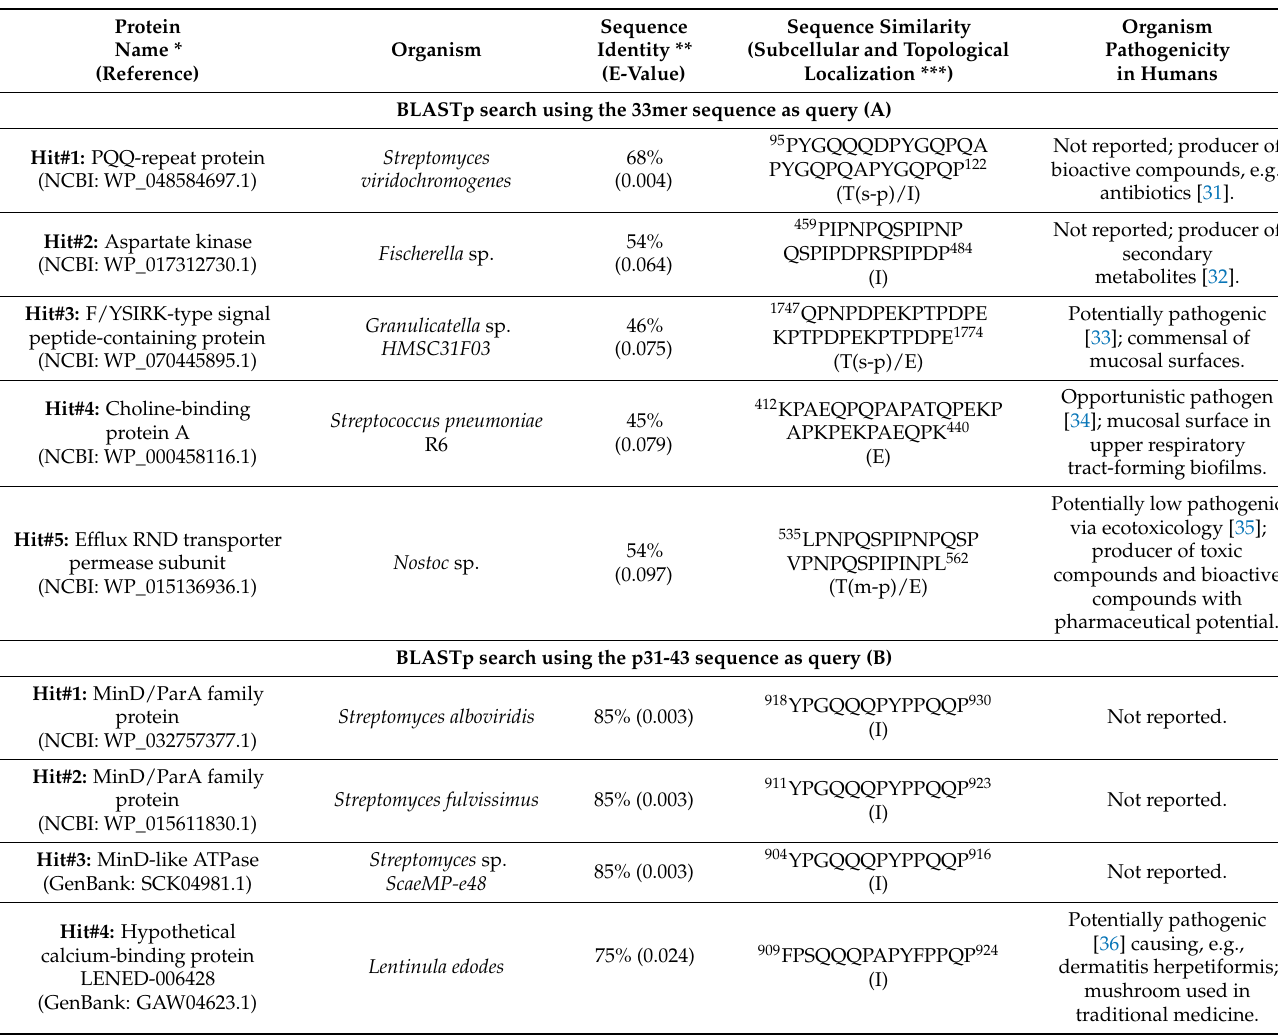
Table 1. Sequence similarity of target protein regions found for the 33-mer (A) and p31-43 (B) peptides of α